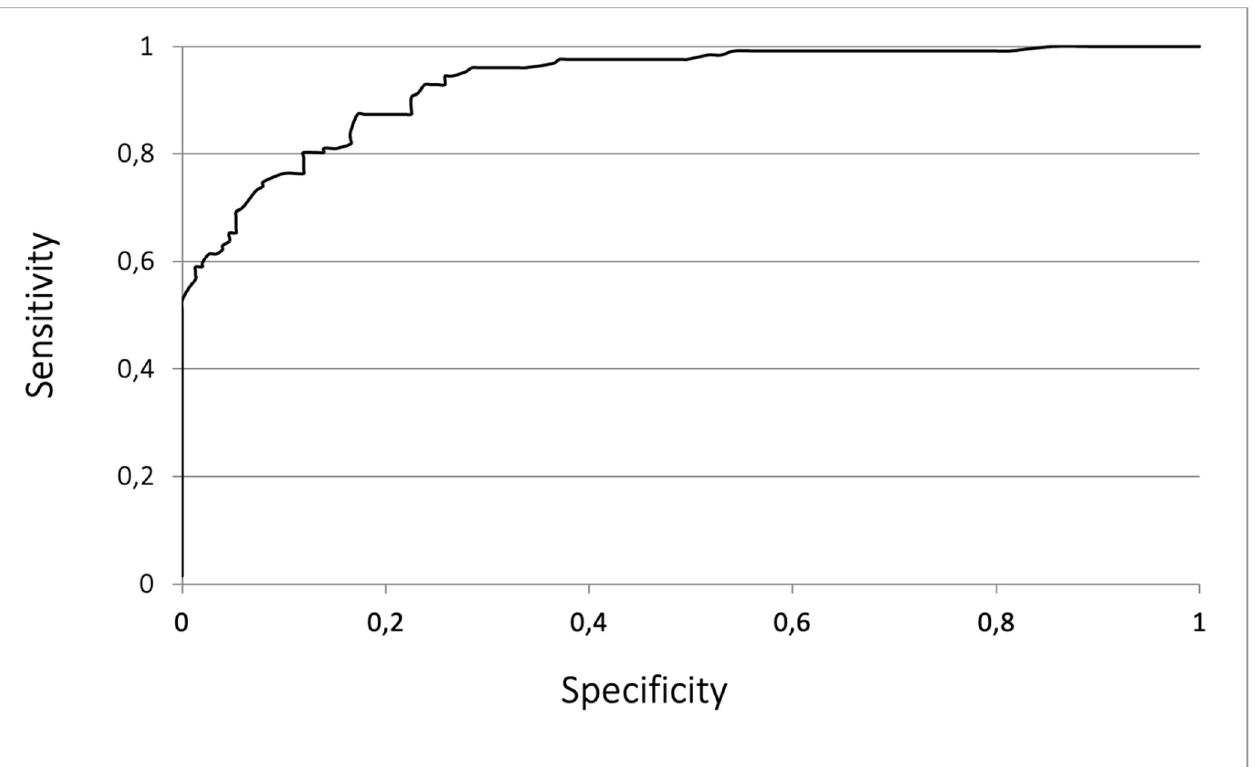
Figure 2. Receiver operating curve for the risk of bronchopulmonary dysplasia including the four-component risk factors’ model (area under the curve = 0.932). Table 3. Scores of particular risk factors in the predictive model for bronchopulmonary